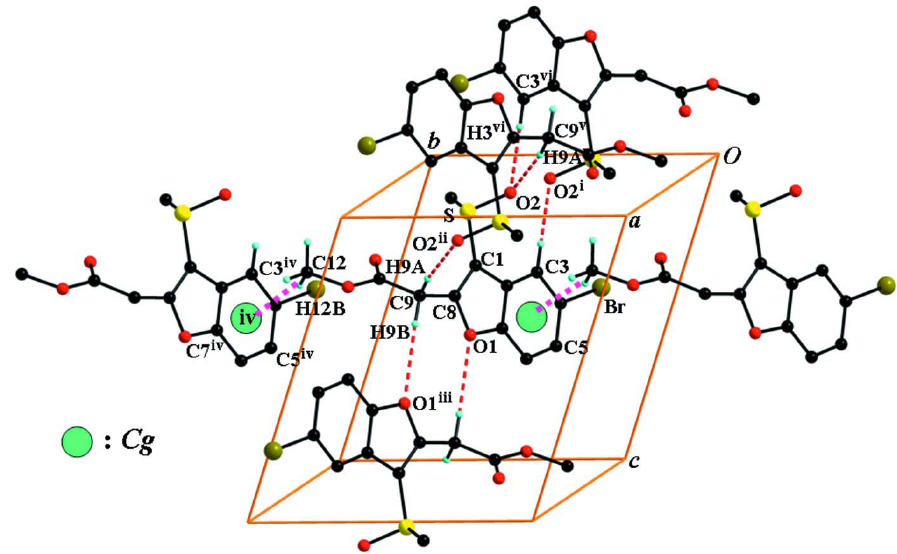
Figure 2 A view of the crystal packing of compound (I), showing the C—H··· π and C—H···O interactions as dotted lines. Cg denotes the ring centroid. [Symmetry codes: (i) - x + 1, - y + 1, -zz; (ii) - x + 2, - y + 1, - z + 1; (iii) - x + 2, - y + 1, - z ; (iv) x , y + 1, z ; (v) - x + 2, - y + 1, - z ; (vi) - x + 1, - y + 1, - z .] Methyl 2-(5-bromo-3-methylsulfinyl-1-benzofuran-2-yl)acetate Crystal